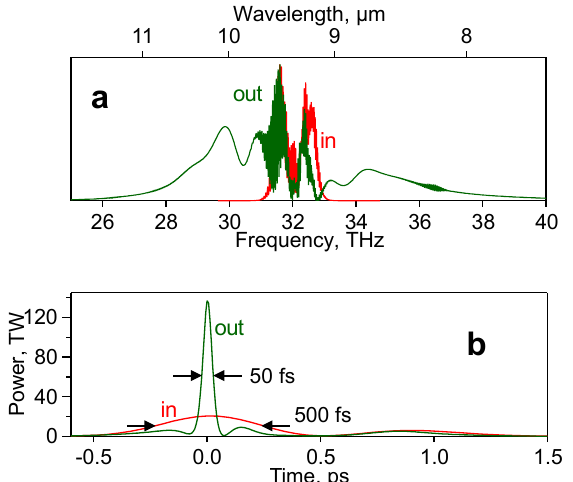
Fig. 5. Calculated spectrum (a) and temporal pulse structure (b) of a pulse before ("in") and after ("out") the post-compression in 15 mm thick KCl and BaF 2 plates. Input pulse corresponds to the 500 fs, 14 J output from the laser amplifier (Fig. 3